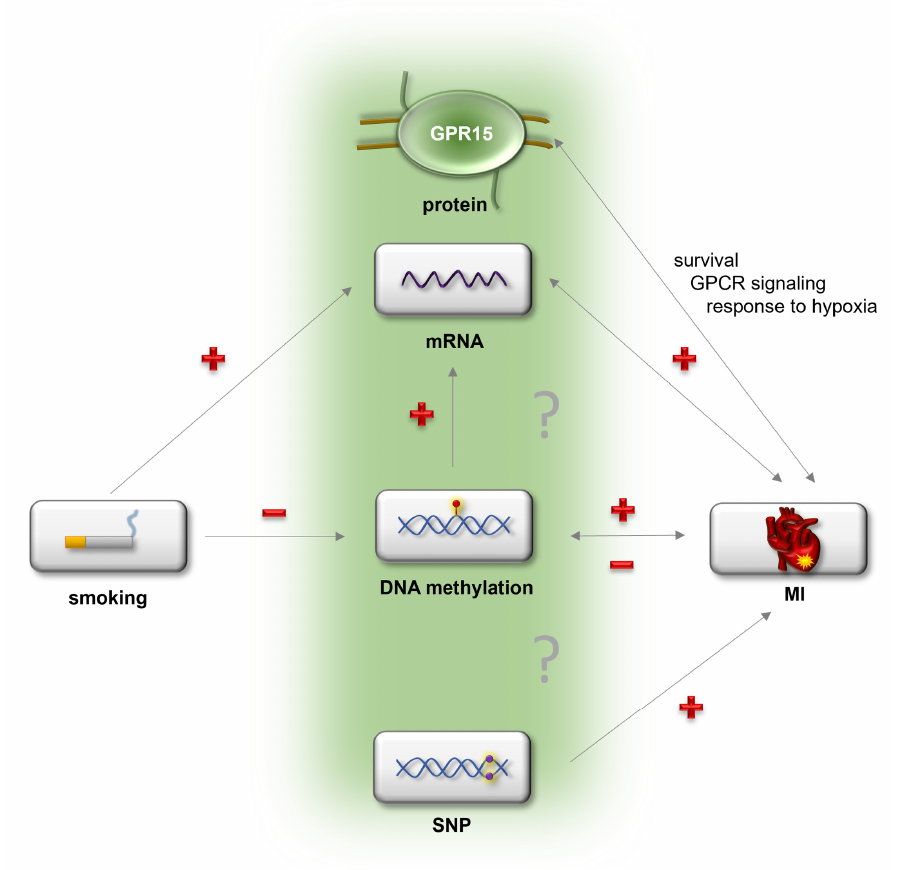
Figure 7. Proposed model of the potential connection between GPR15 and myocardial infarction. Possibly, smoking as a major risk factor for myocardial infarction (MI) might change blood cell com- position and thereby GPR15 mRNA expression as well as GPR15 DNA methylation. Myocardial infarction is associated with elevated GPR15 mRNA expression as well as decreased GPR15 DNA methylation. The effect of smoking on MI is mediated by GPR15 mRNA expression. Gpr15 affects survival as well as signaling and gene expression related to signaling and response to hypoxia after MI. The SNP rs2230344 within the GPR15 gene is associated with early-onset MI. “+” = upregulation, “ − ” = downregulation.